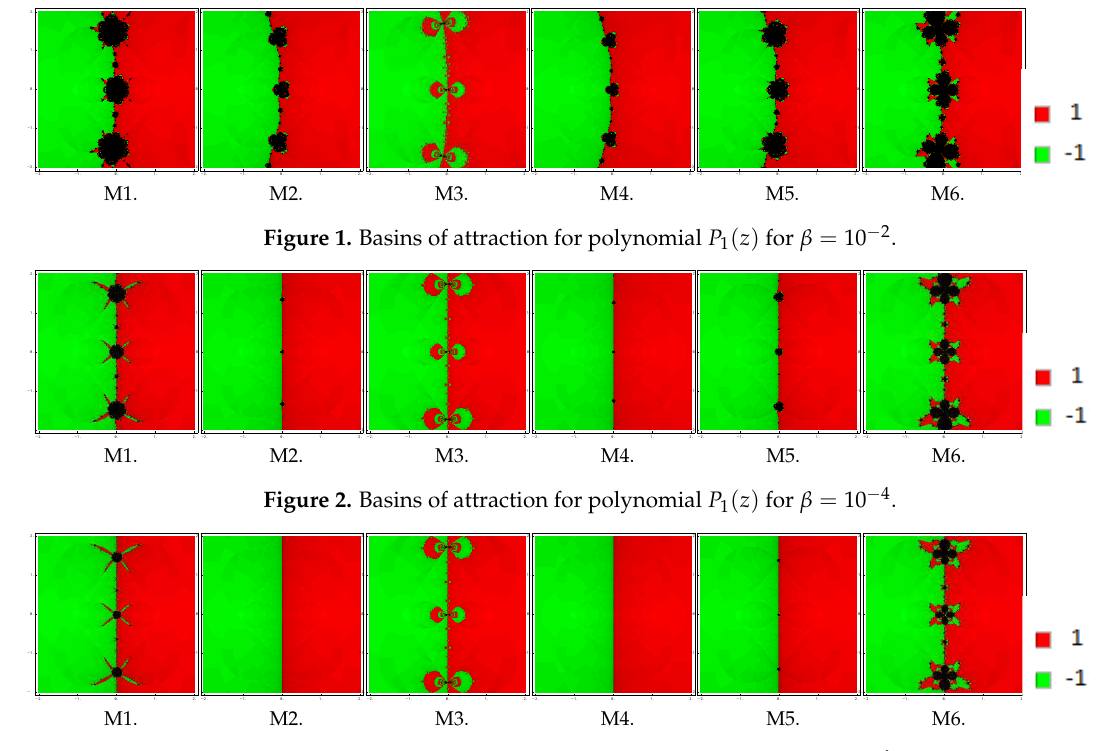
Figure 3. Basins of attraction for polynomial P 1 ( z ) for β = 10 − 6 .